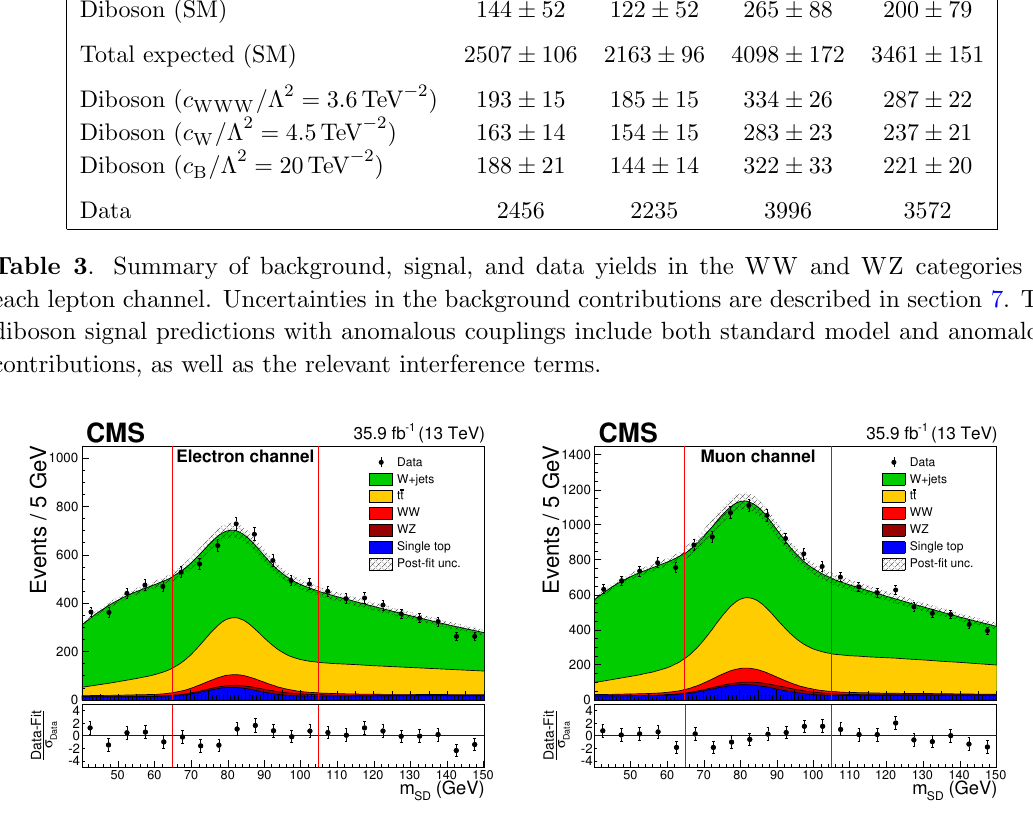
Figure 3 . Final result of the two-dimensional (cid:12)t in the electron (left) and muon (right) channels, showing the m SD